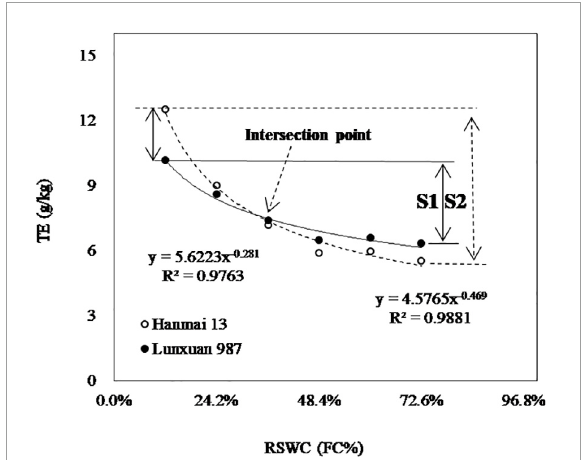
FIGURE7 Sensitivity analysis and comparison of transpiration efficiency ( TE ) between any two cultivars, taking cultivars Hanmai 13 and Lunxuan 987 for example. The rank of sensitivity is inverse to the rank of TE FC . Sensitivity of Hanmai 13 (S2) is higher than that of Lunxuan 987 (S1). When comparing between two cultivars, TE of Hanmai 13 is higher than that of Lunxuan 987 to the left of the intersection point. The rank is reversed to the right of the intersection point. RSWC , soil water content. FC , field capacity. Data are means of 4 replicates at the same RSWC